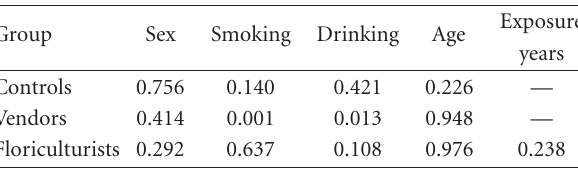
Table 3: E ff ect of various characteristics of the studied groups with respect to the comet assay results (P value shown). Smokers: indi- viduals who smoke at least 5 cigarettes/day. Drinkers: individuals who consume at least 45 g of alcohol/day. Sex, smoking, and drink- ing were analyzed with the general linear model. Age and exposure years were evaluated with the Pearson’s correlation